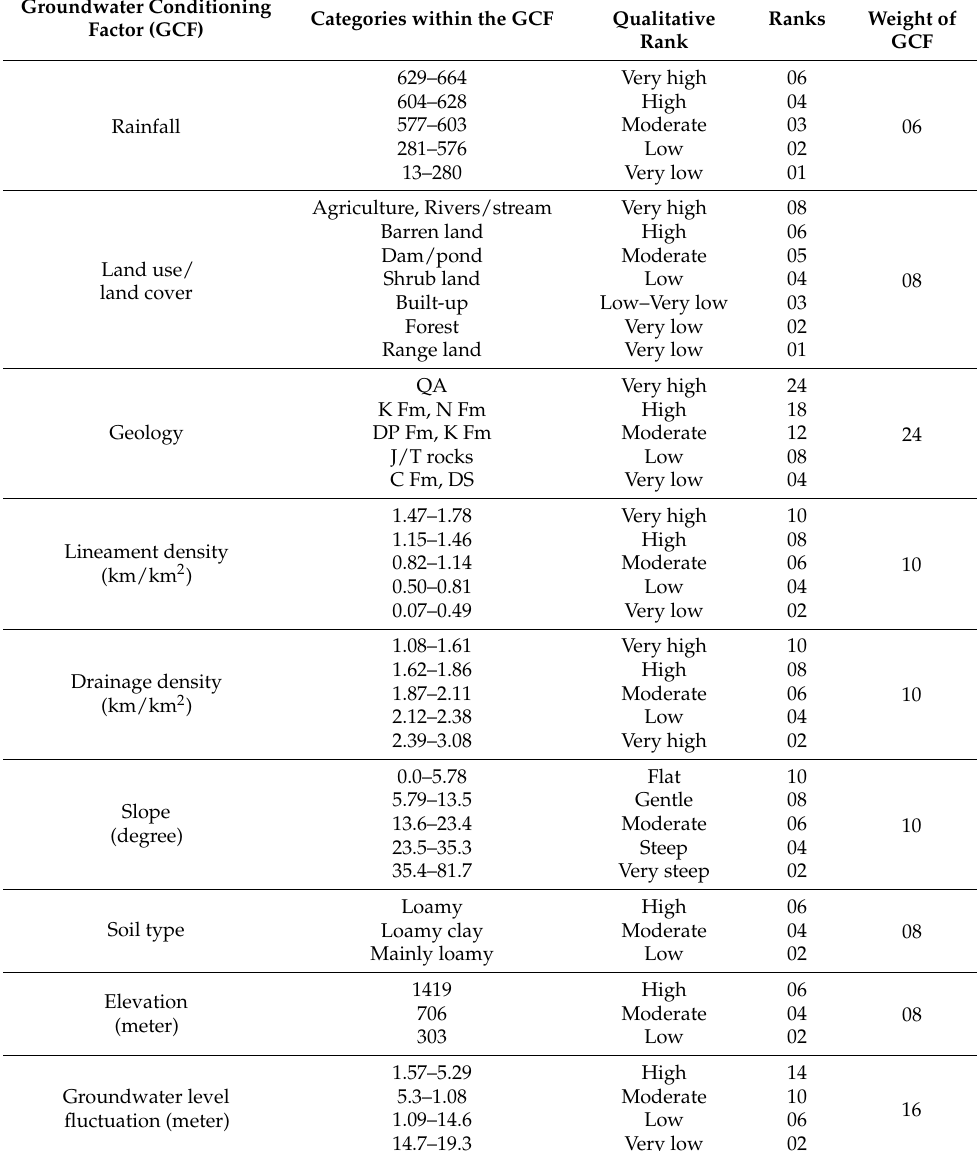
Table 4. Classification of weight and ranks of